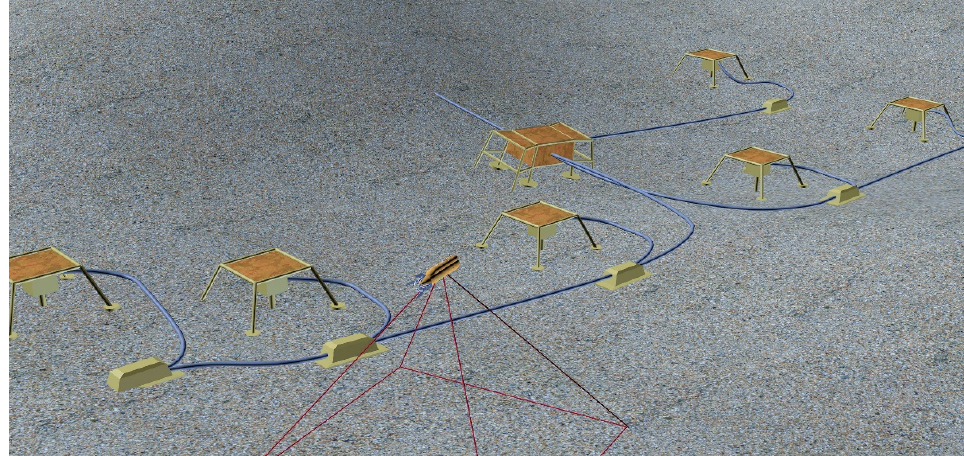
Figure 1. Local cluster of subsea production system (SPS).